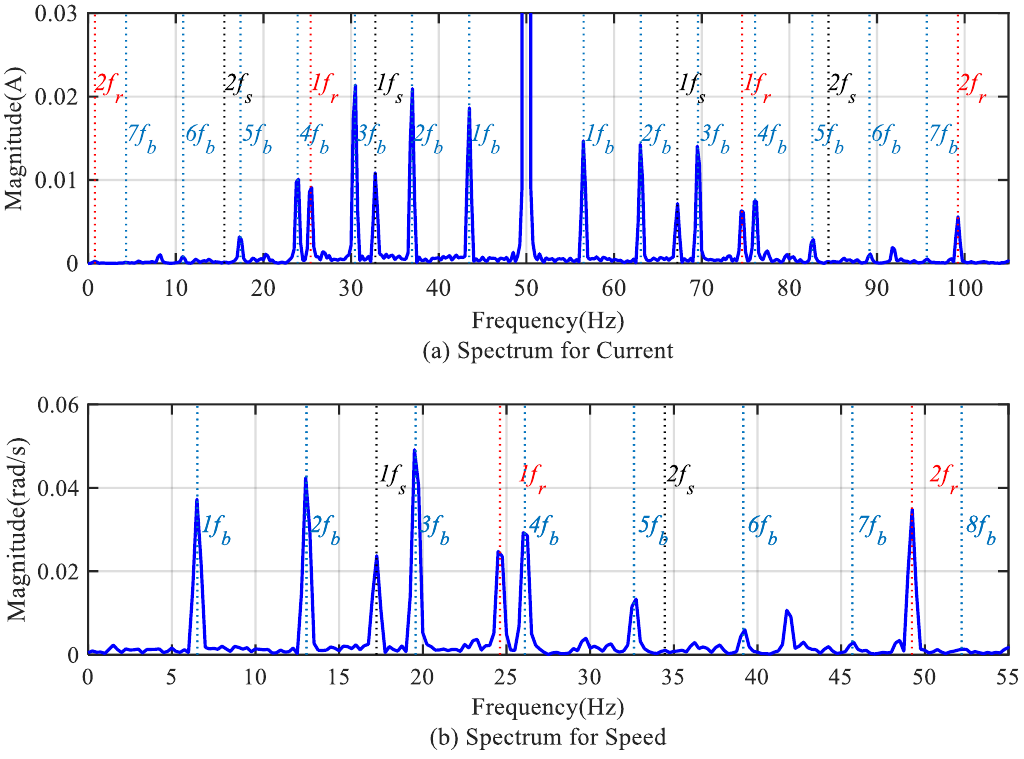
Figure 10. Spectra of current and speed under belt defects ( P 0 = 300 N).